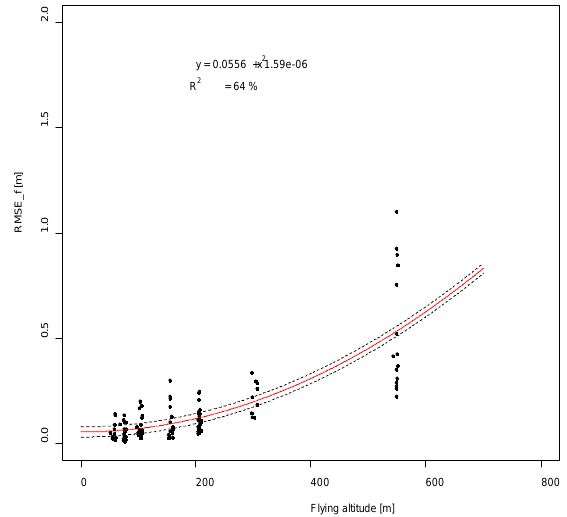
Figure 8. Scatterplot setting the residuals’ RMSE (determined with GCP reference) in relation to the flight altitude. The red line represents the linear fit using a quadratic growth; the dotted line represents the 95% confidence interval.